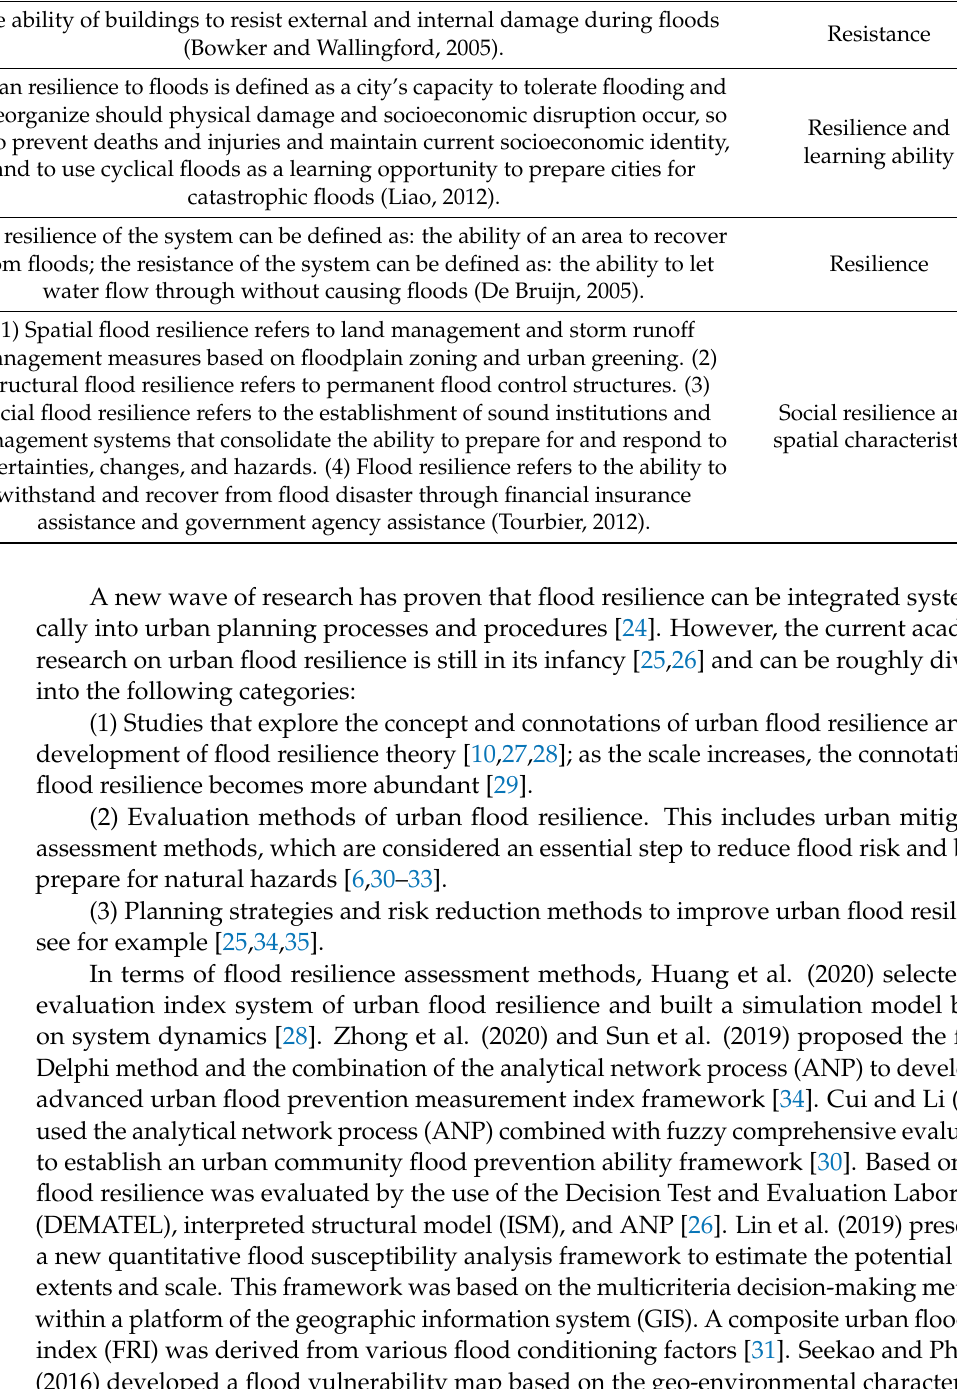
Table 1. Comparison of the concept of flood resilience at different scales.